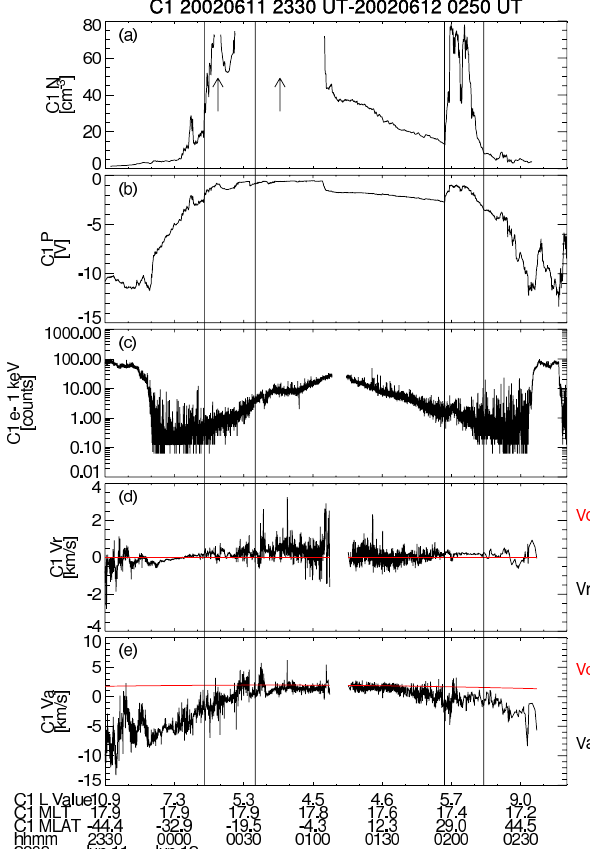
Fig. 3. C1 data including inbound and outbound plume crossings from 23:30UT on 11 June 2002 to 02:50UT on 12 June 2002. The figure shows (a) the number density, (b) spacecraft potential, (c) electron counts at 1keV with a pitch angle of 90 degrees, and (d) radial and (e) azimuthal components of convection velocity to- gether with corotation velocity. Spacecraft locations are noted in the bottom of the figure. Each plume crossing is indicated by pairs of vertical lines. Two arrows in panel (a) indicate data gaps caused by density values above 80cm − 3 , which is the upper threshold of the WHISPER instrument.